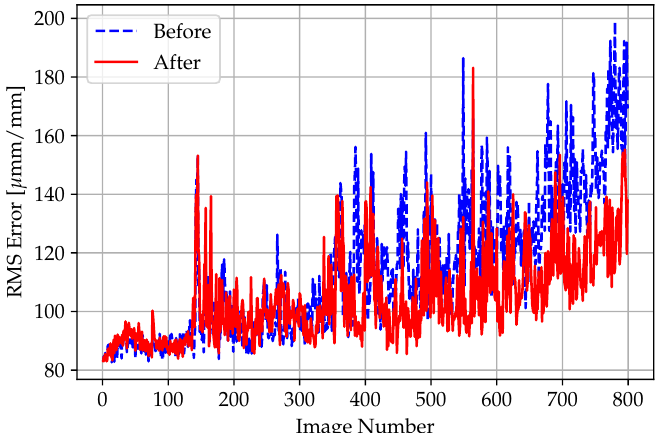
Figure 17. The RMS strain error between the stereo-DIC and 2D-DIC measurements, before and after the error compensation was applied, for Test